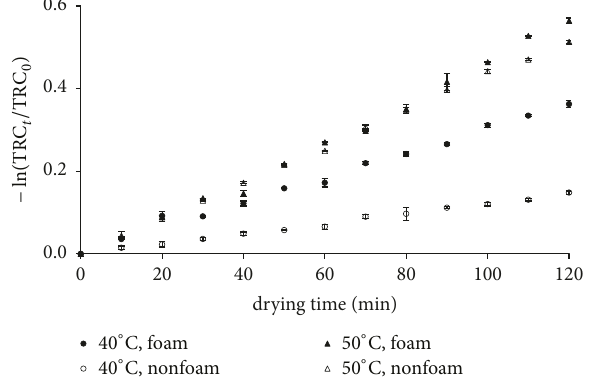
Figure 5: The colour degradation at various drying